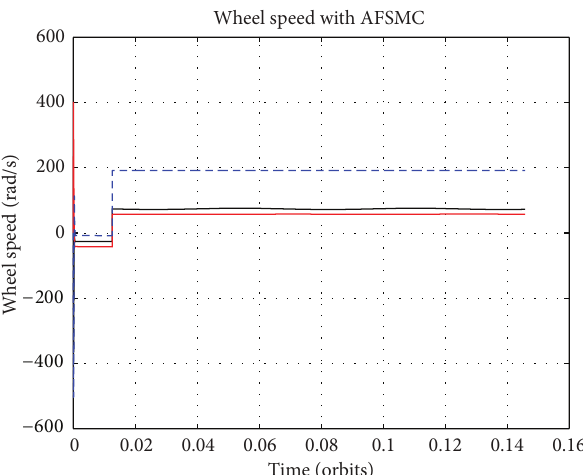
Figure 13: Scenario 5 nadir pointing control results using three wheels: wheel speed.